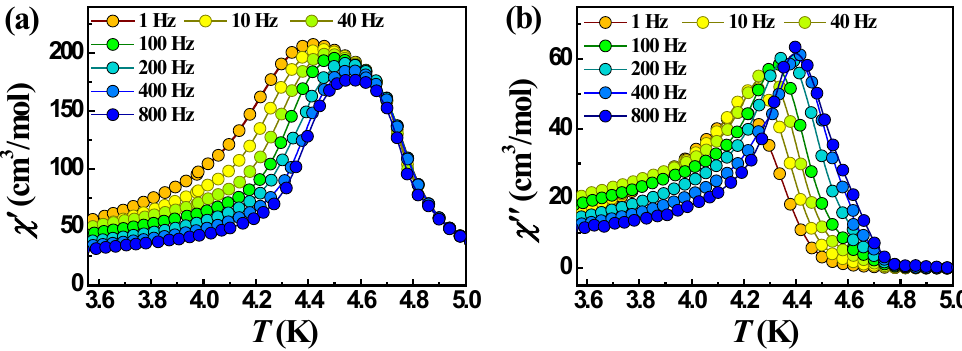
Figure 10. Temperature dependencies of χ ’ ( a ) and χ″ ( b ) at different frequencies for complex 1 in a zero dc field.